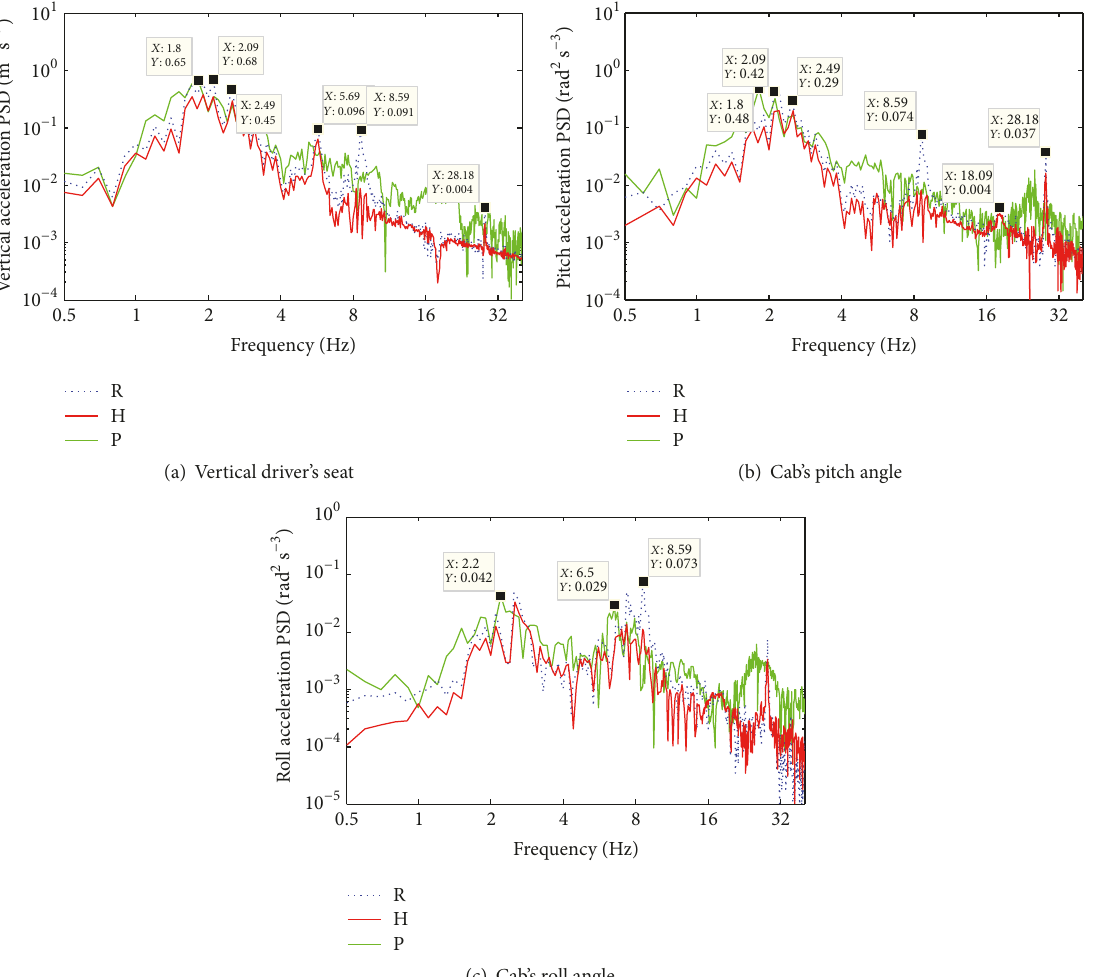
Figure 12: The acceleration PSD responses on a high-density soil ground at low excitation frequency 28 Hz of the